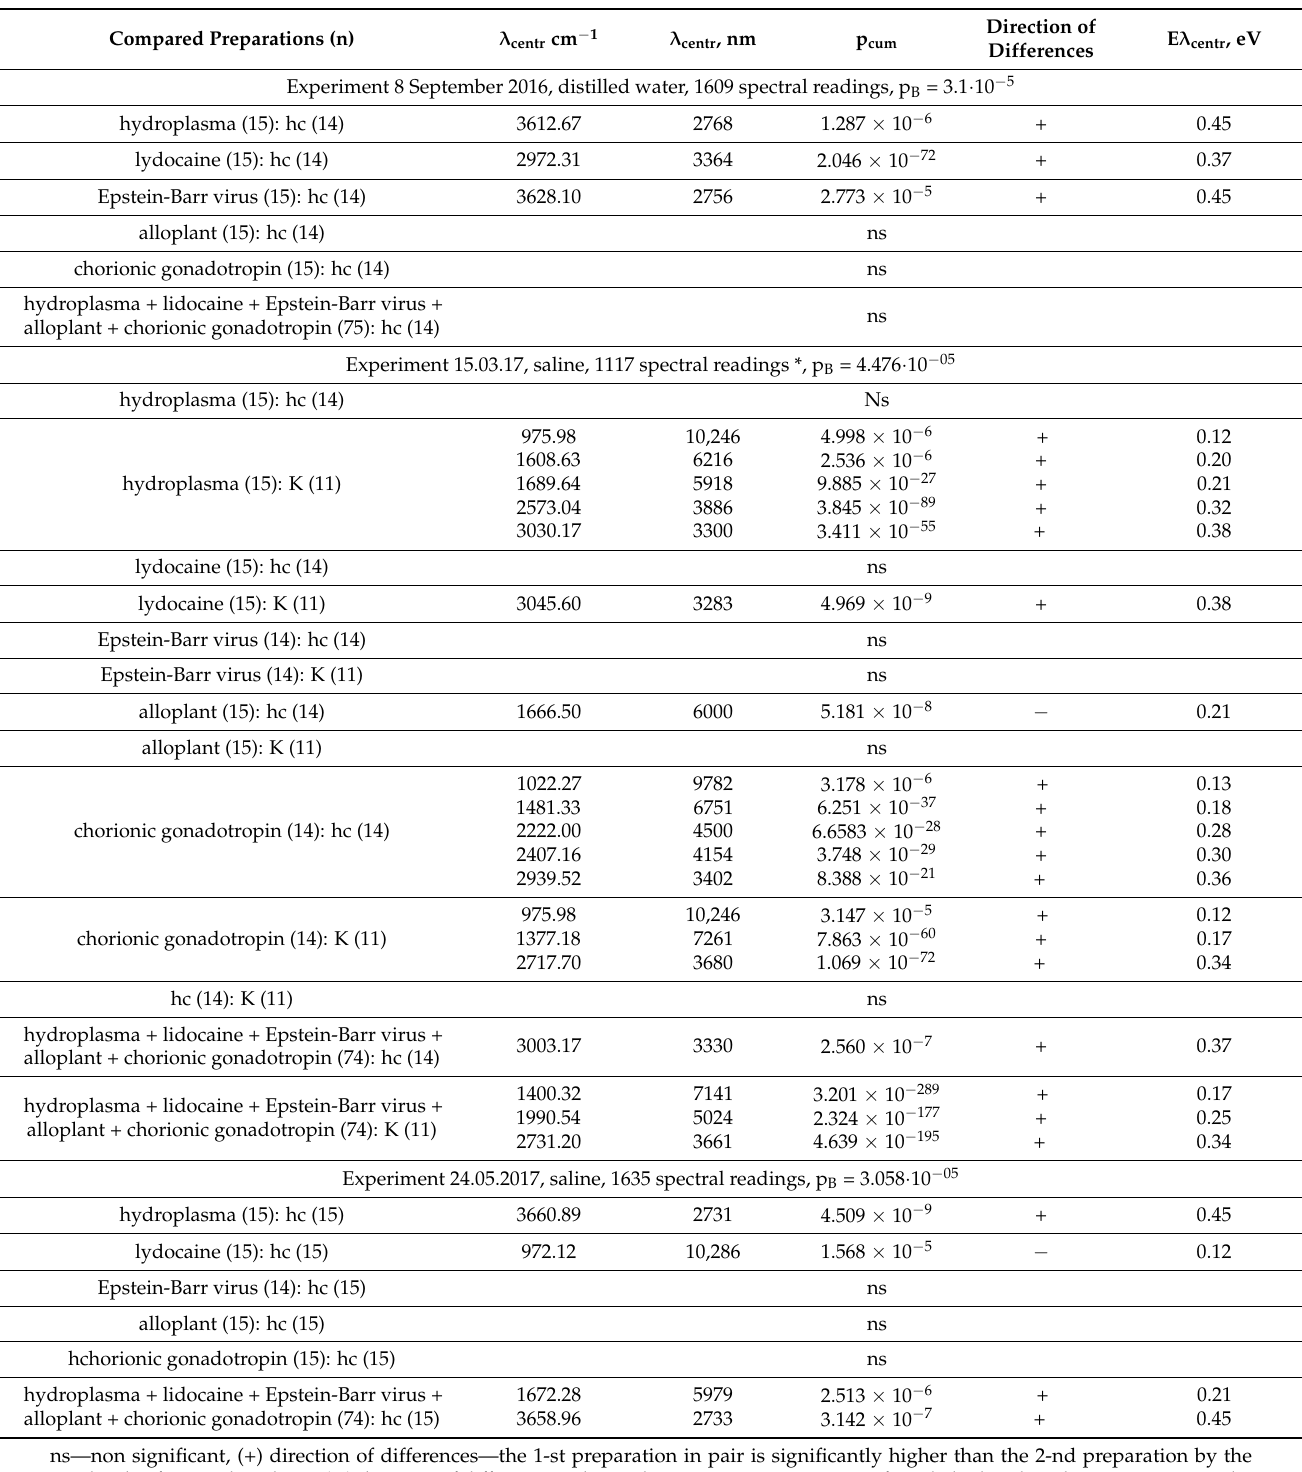
Table 1. Bands of far infrared transmission spectra with significant distinctions between ensembles of homeopathic-like preparations and hidden control “hc”/apparent control